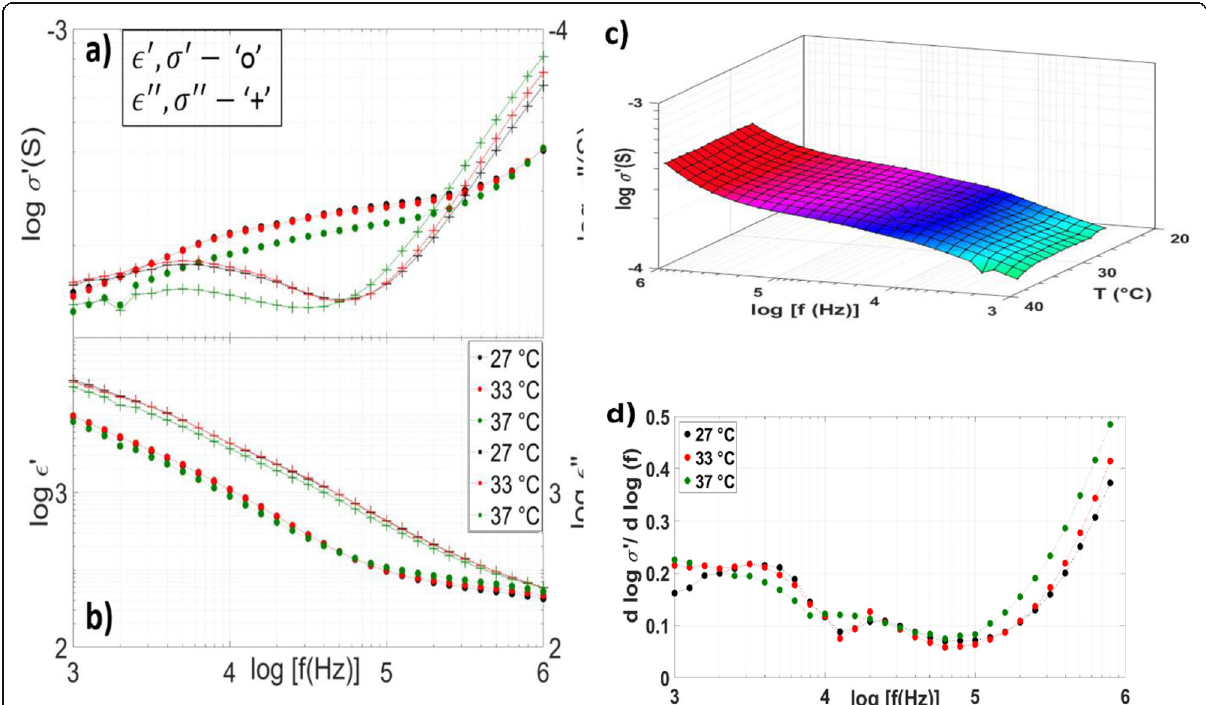
Fig. 3 KBT-PVA-PNIPAm temperature-dependent spectroscopy. Real and imaginary conductivity (top left), dielectric constant (bottom left), electric modulus (right) at 27 °C (black), 33 °C (red), and 37 °C (green) of bulk PNIPAm with dispersed KF-BaTiO 3